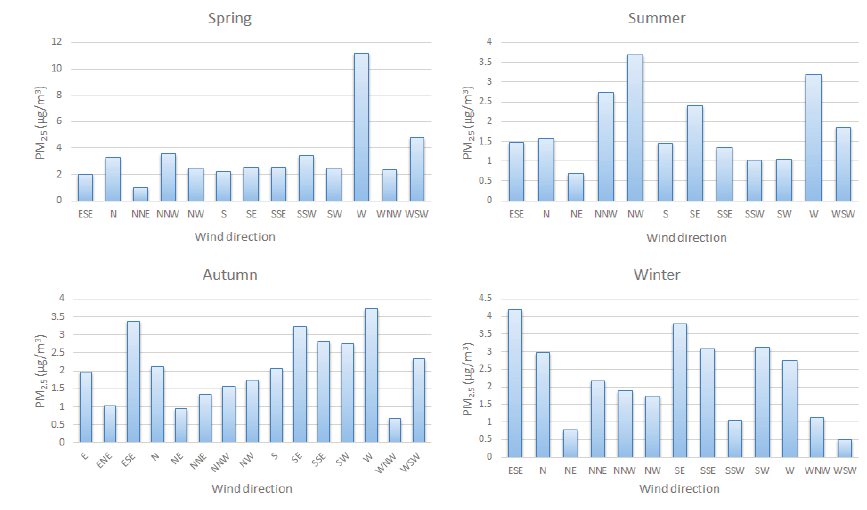
Figure 8. The relationship between PM 2.5 and wind direction in a year.